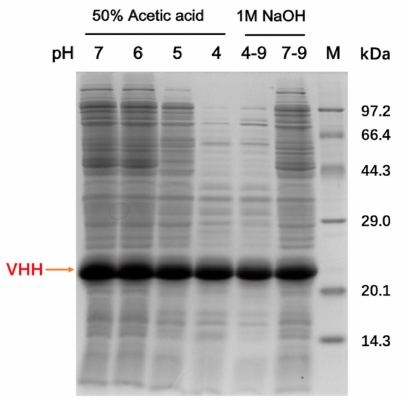
Figure 1. Acetic acid-assisted precipitation of host cell proteins. Lane M is the protein molecular weight marker; 50% acetic acid solution was added dropwise into the crude cell extract. The supernatant treated with di ff erent pH values were analyzed by SDS-polyacrylamide gel electrophoresis (SDS-PAGE) and gray scanning. After precipitation, the supernatant was readjusted to pH 9 (Lanes 4–9). The lysate, which directly adjusted from pH 7 to pH 9, was set as a control (Lanes